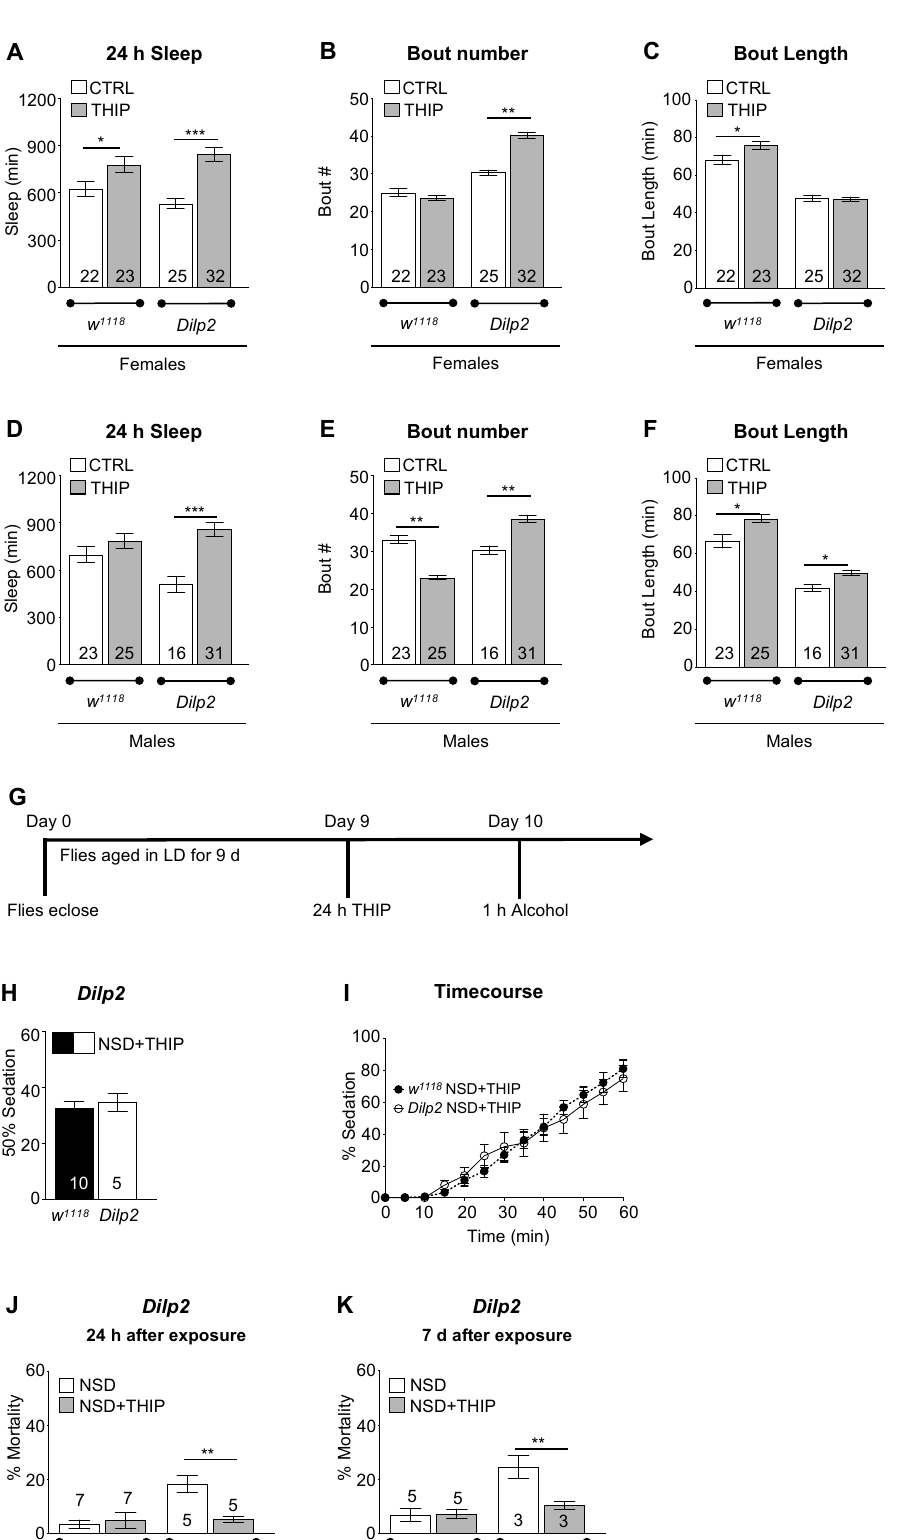
Figure 7. Pharmacologically increasing sleep in short-sleeping Dilp2 mutants significantly reduces alcohol-induced mortality. ( A – F ) Comparison of sleep profiles between w 1118 and THIP-fed w 1118 and Dilp2 flies housed in LD cycles. Compared to non-THIP-fed female w 1118 and Dilp2 flies, THIP-fed flies demonstrated significantly increased total sleep (( A ) [ANOVA: F 3,98 = 10.95, p < 0.001]; * specifies significant differences between groups as indicated by Bonferroni post hoc analyses). Dilp2 THIP- fed females had significantly higher number of sleep bouts compared to non-THIP-fed controls (( B )